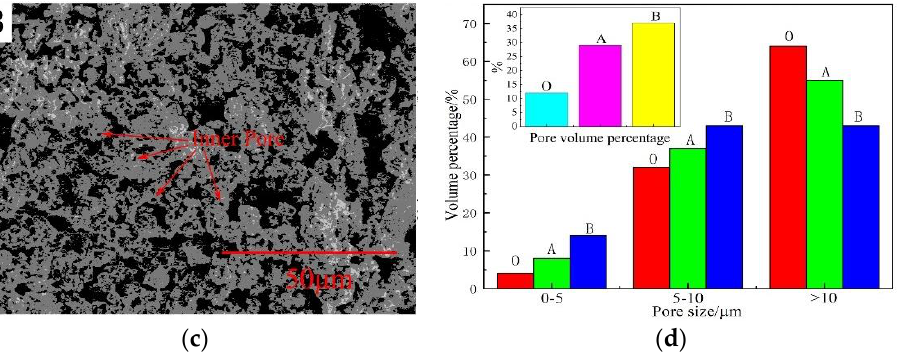
Figure 10. SEM images of samples: ( a ) O, bituminous coal char; ( b ) A, bituminous coal char gasified in CO 2 /H 2 O=3/1 atmosphere; ( c ) B, bituminous coal char gasified in CO 2 /H 2 O = 1/3 atmosphere and ( d ) pore volume histogram.